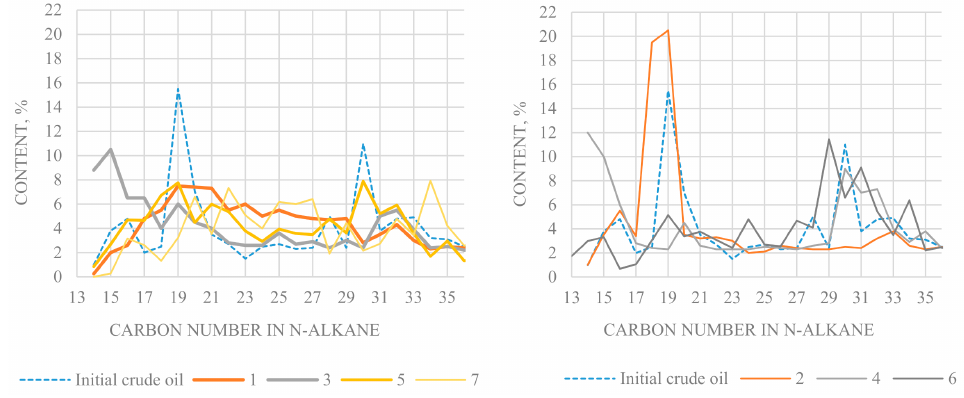
Figure 5. Molecular mass distribution of n-alkanes in the original and converted oil during experi- ments 1–7.